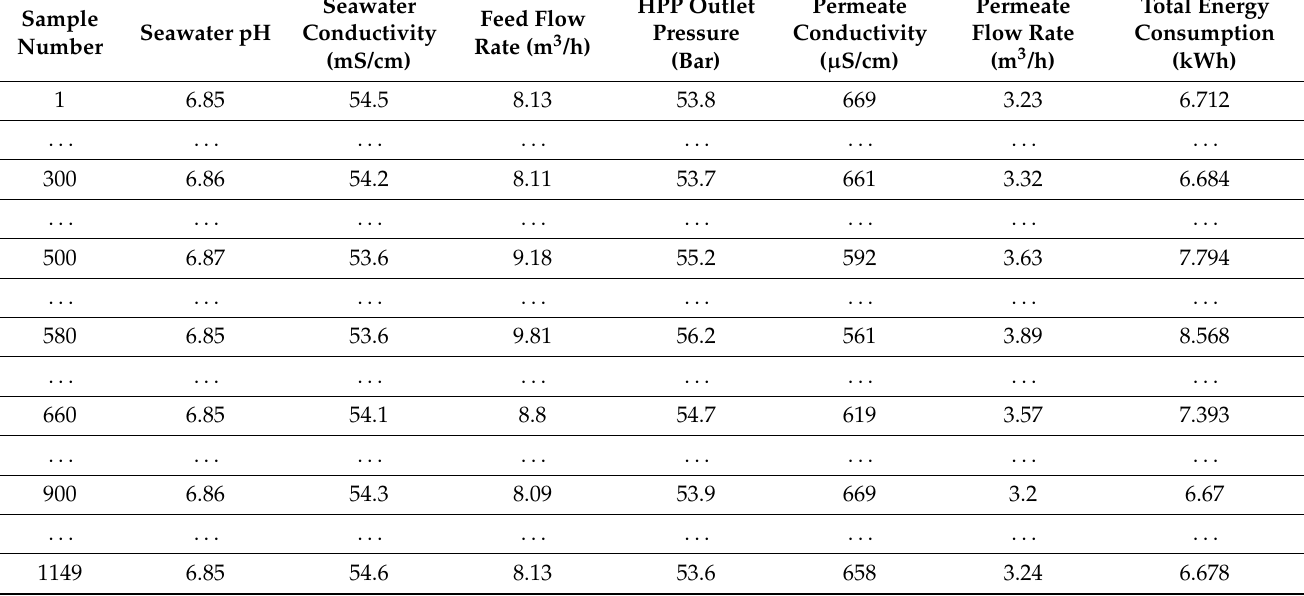
Table 2. Sample of the data recorded during a 24-h